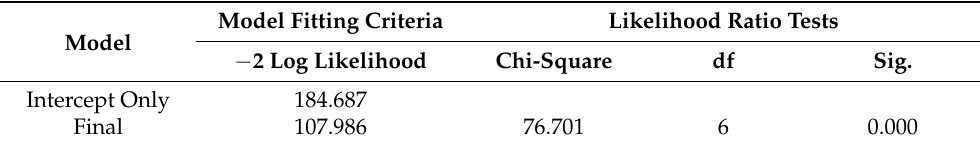
Table 3. Model fitting